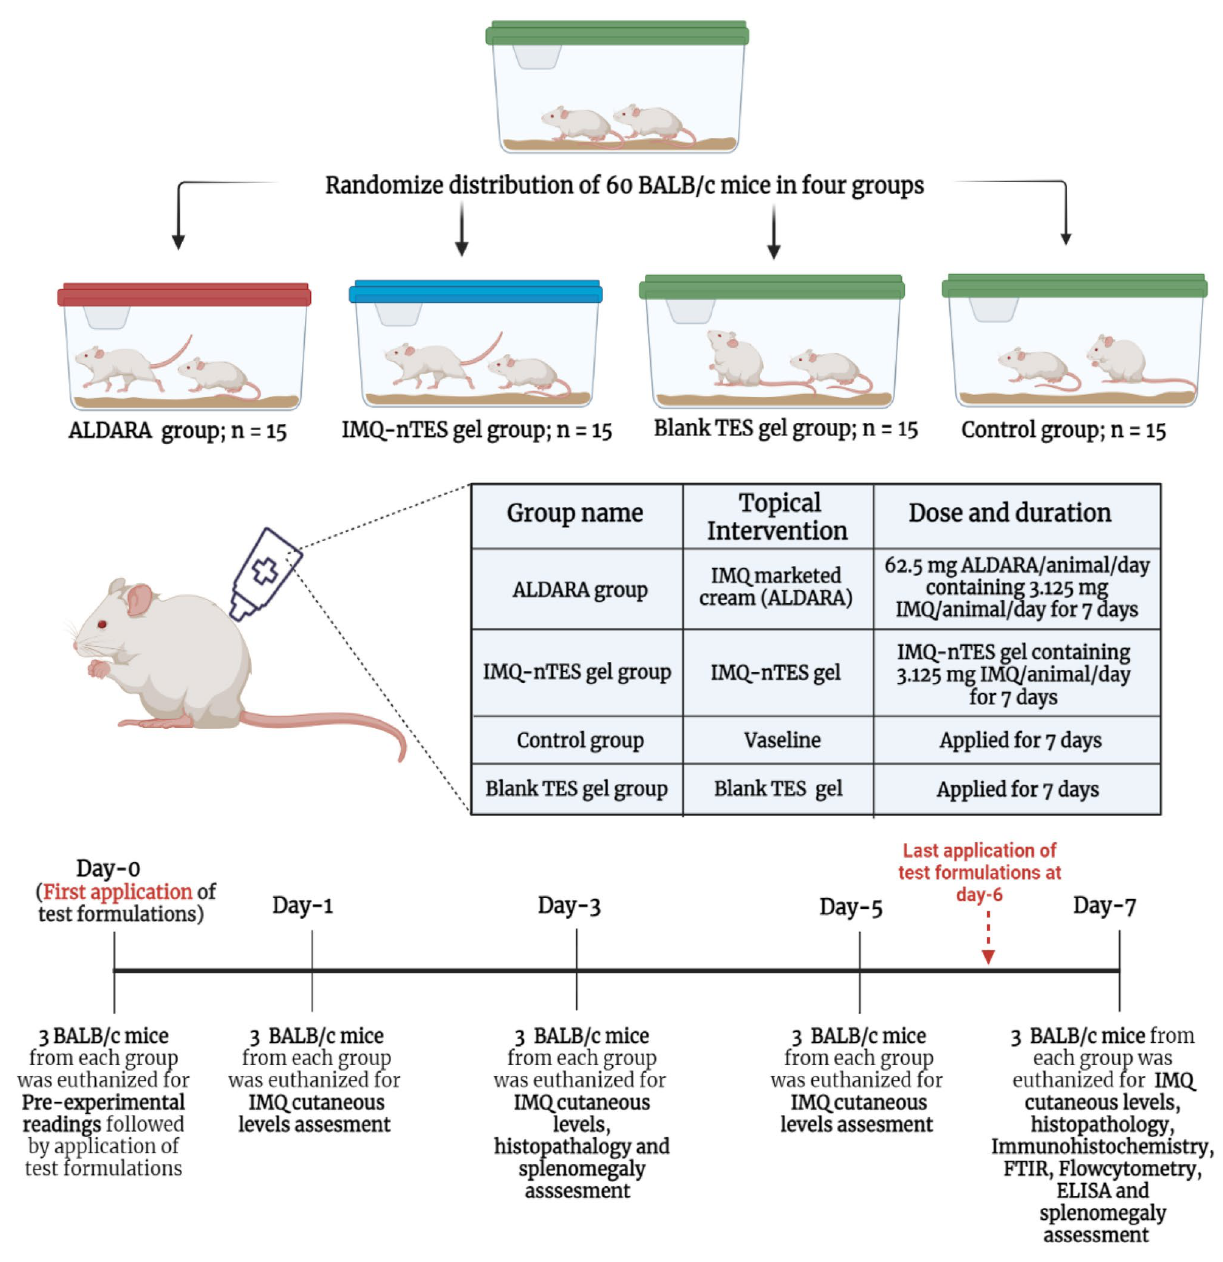
Figure 2. Experimental design for in vivo cutaneous toxicity assessment. Created with